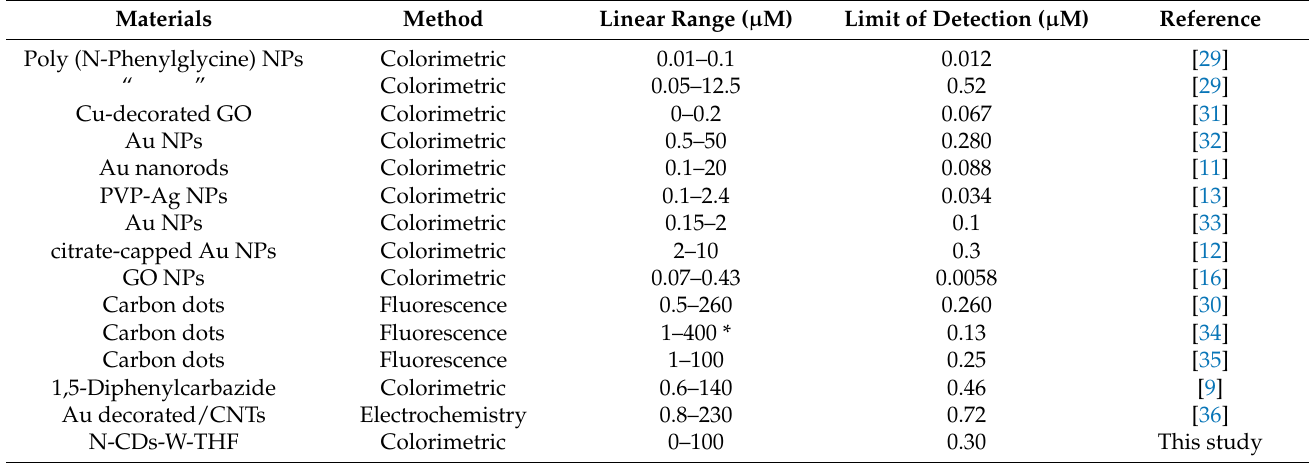
Table 3. Comparison of the performances of various techniques and materials for